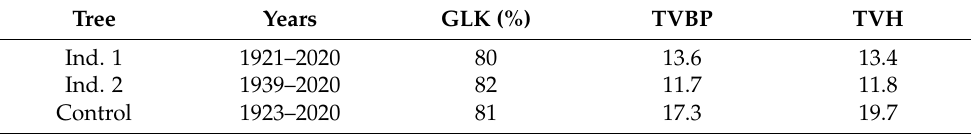
Table 1. Assessment of the quality of the analysed individual sequences based on the characteristics. Tree